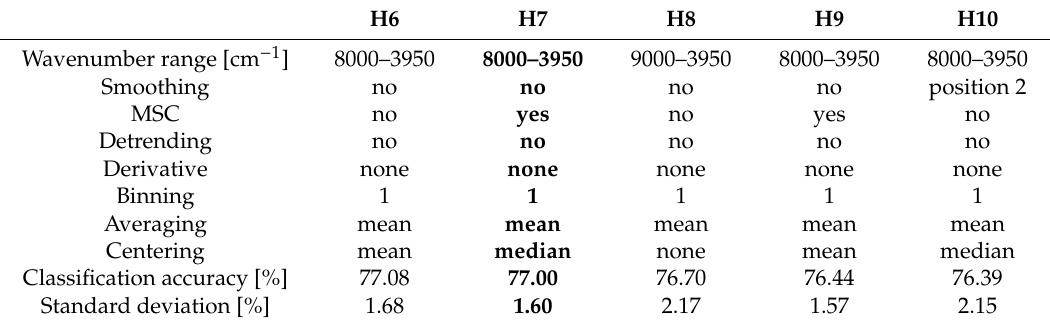
Table 5. Pre-processingstrategieswiththehighestclassificationaccuraciesofall50,545combinations—part2. The selection based on LDA in a 5-fold repetition of the nested cv. The classification accuracies shown are based on all 212 walnut samples and a 20-fold repetition of the cv. The highlighted ( bold ) pre-processing combination H7 has been chosen for further determination of the geographical origin of walnuts.